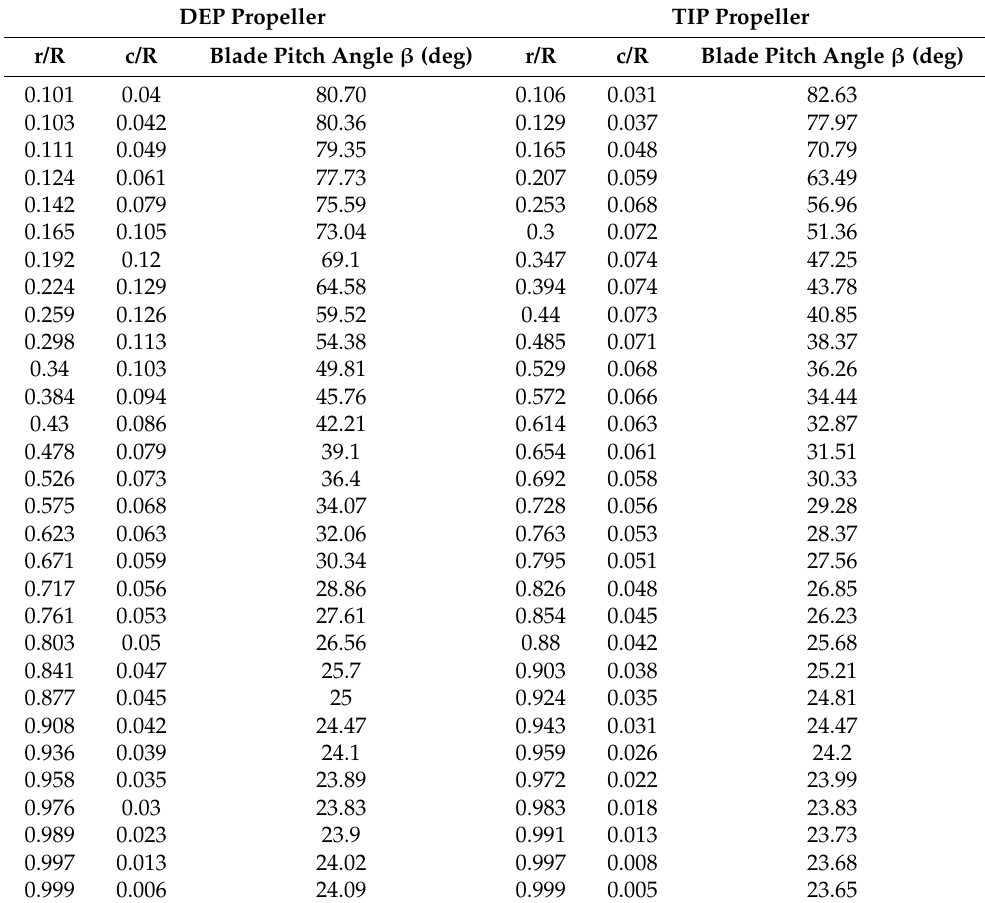
Table 6. DEP and TIP propeller geometries (r, blade station, R, blade radius, c, blade local chord). DEP Propeller TIP Propeller